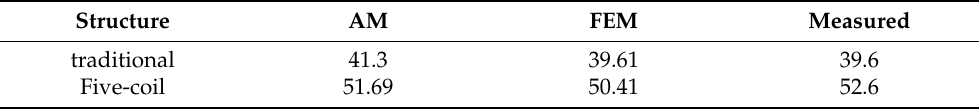
Table 7. The Comparison of Levitation Force (kN).